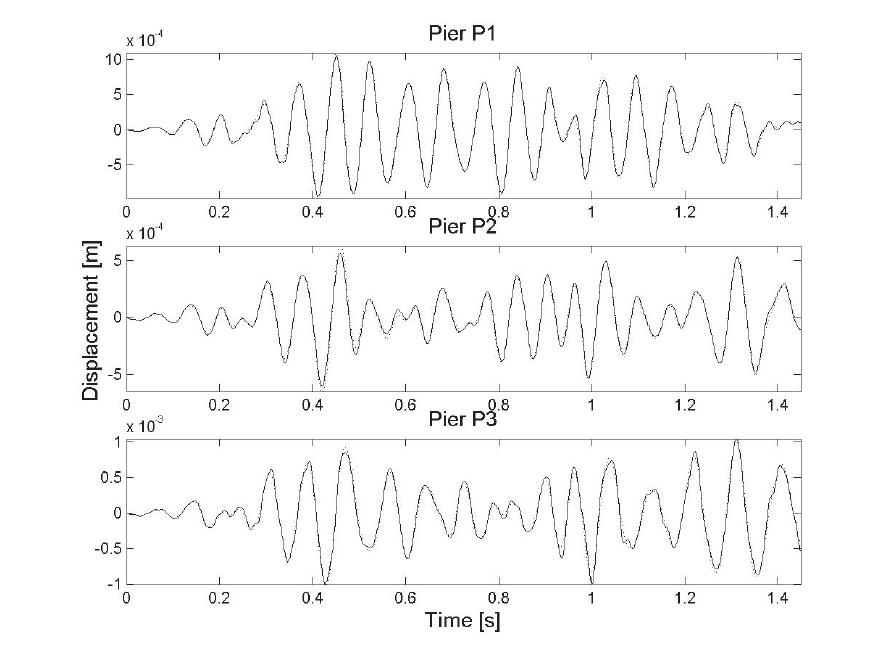
Fig. 8. Comparison between the displacements obtained by numerical integration of the measured accelerations (dotted line) and those predicted by the model (solid